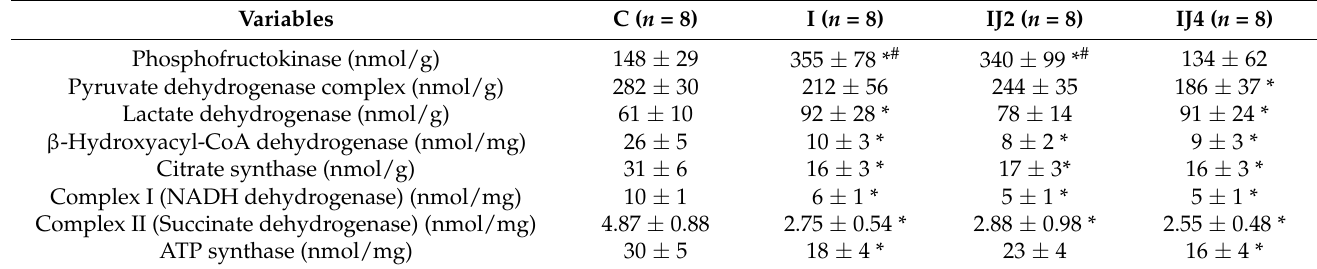
Table 3. Cardiac energy metabolism assessment .